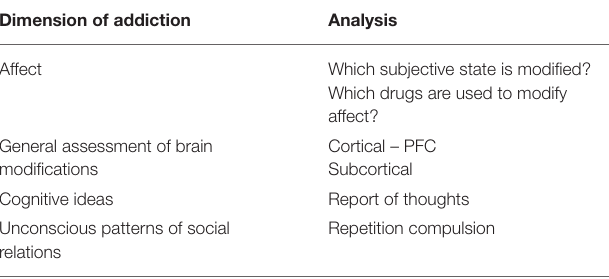
TABLE 2 | A neuropsychoanalytic assessment of the different dimensions of addiction. Dimension of